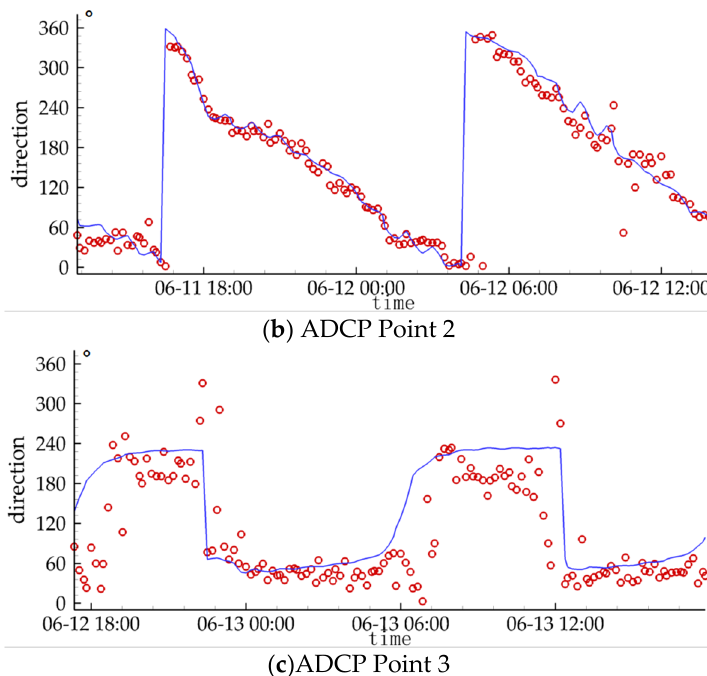
Figure 5. Direction verification.